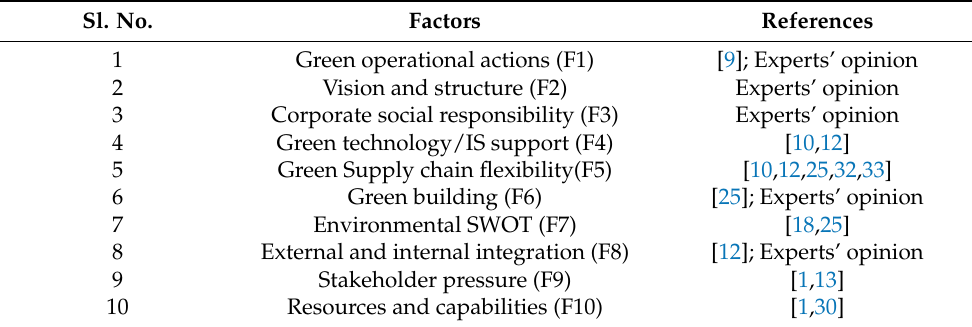
Table 1. Identified factors influencing green operations strategies in healthcare. Sl.